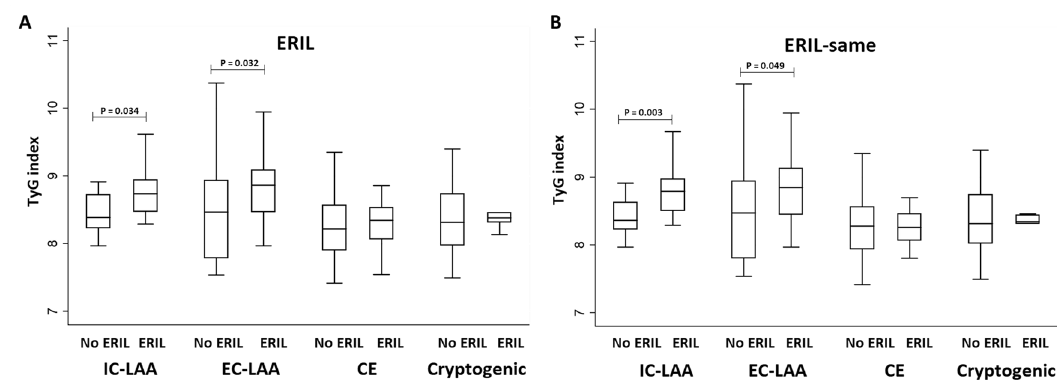
Figure 1. Comparisons of the TyG index values according to the presence of ERIL by stroke mechanisms. ERIL = early recurrent ischemic lesion, ERIL-same ERIL within the same vascular territory, TyG index triglyceride-glucose index, IC-LAA intracranial-large artery atherosclerosis, EC-LAA extracranial-large artery atherosclerosis, CE cardioembolism. The TyG index values show statistically significant differences in the presence or absence of ERIL only in patients in the IC-LAA ( P = 0.034) and EC-LAA ( P = 0.032) groups (A) . This difference is observed in the same pattern in ERIL-same (B) , but not clear in ERIL-different.